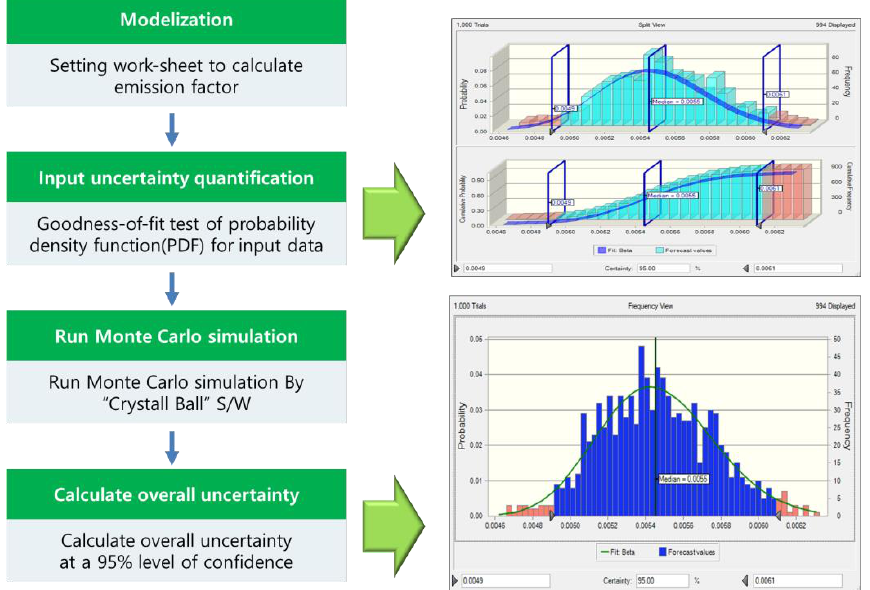
Figure 3. Process of the Monte Carlo Simulation for estimating the uncertainty of the emission factor.